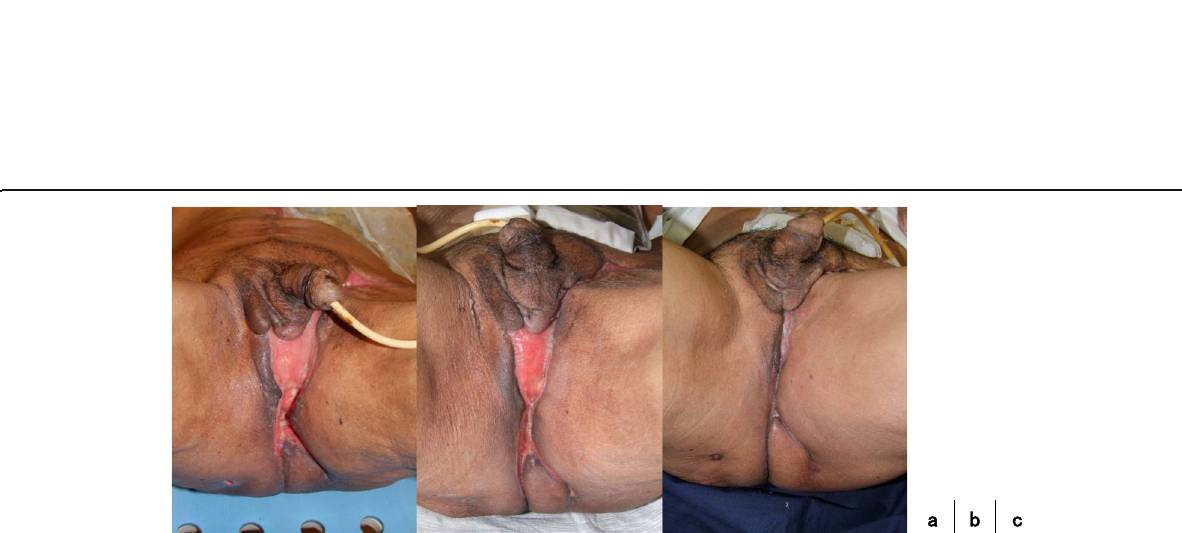
Fig. 7 Cleaned the wound every day ( a ). At discharge ( b ). Healing ( c